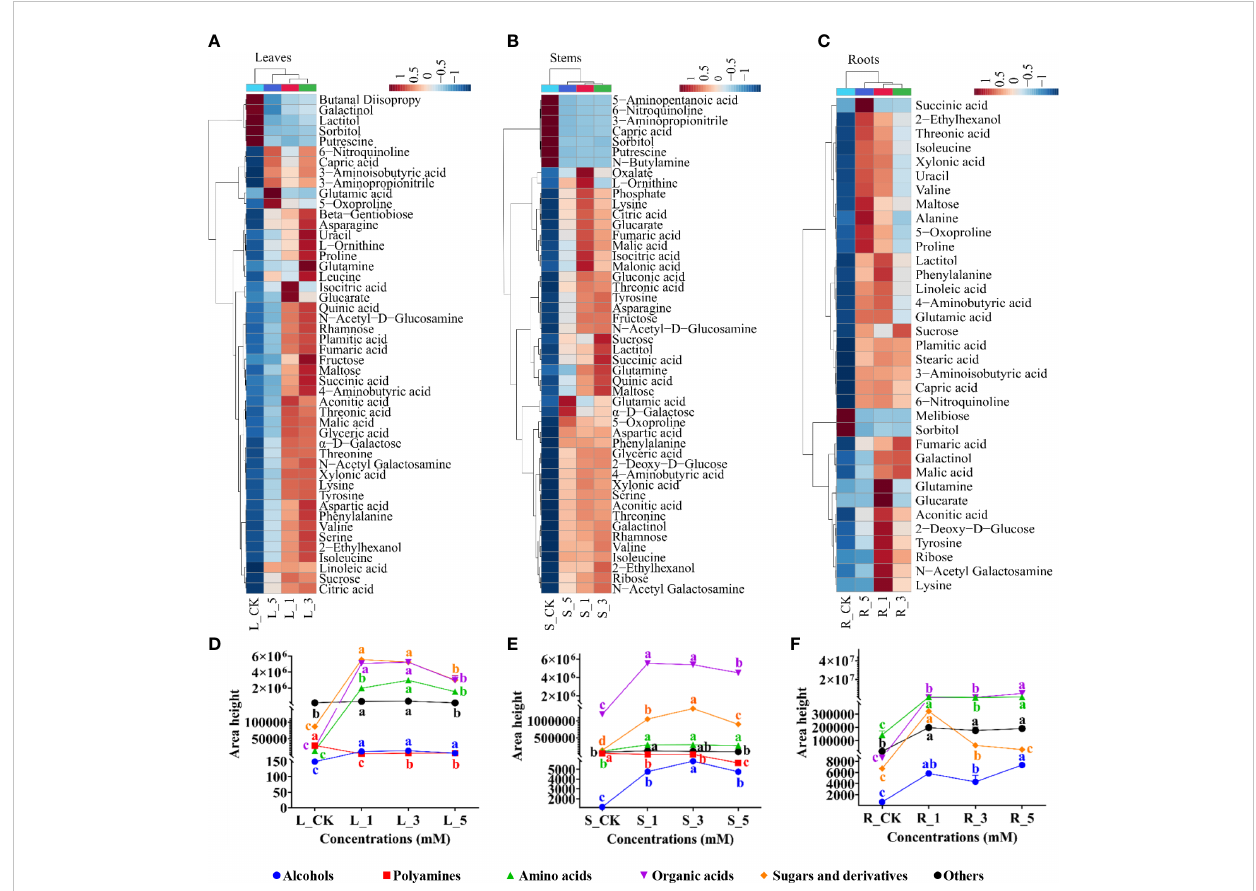
FIGURE 3 Changes in the abundances of the common DAMs in leaves, stems and fi brous roots. (A – C) Represent the leaves, stems and fi brous roots, respectively. (D – F) Represent the relative abundances of the different classes of common DAMs in the leaves, stems and fi brous roots, respectively. Error bars indicate the standard error (SE) calculated from six biological replicates. Different letters indicate statistically signi fi cant differences among the treatments by Duncan ’ s multiple range test at p <